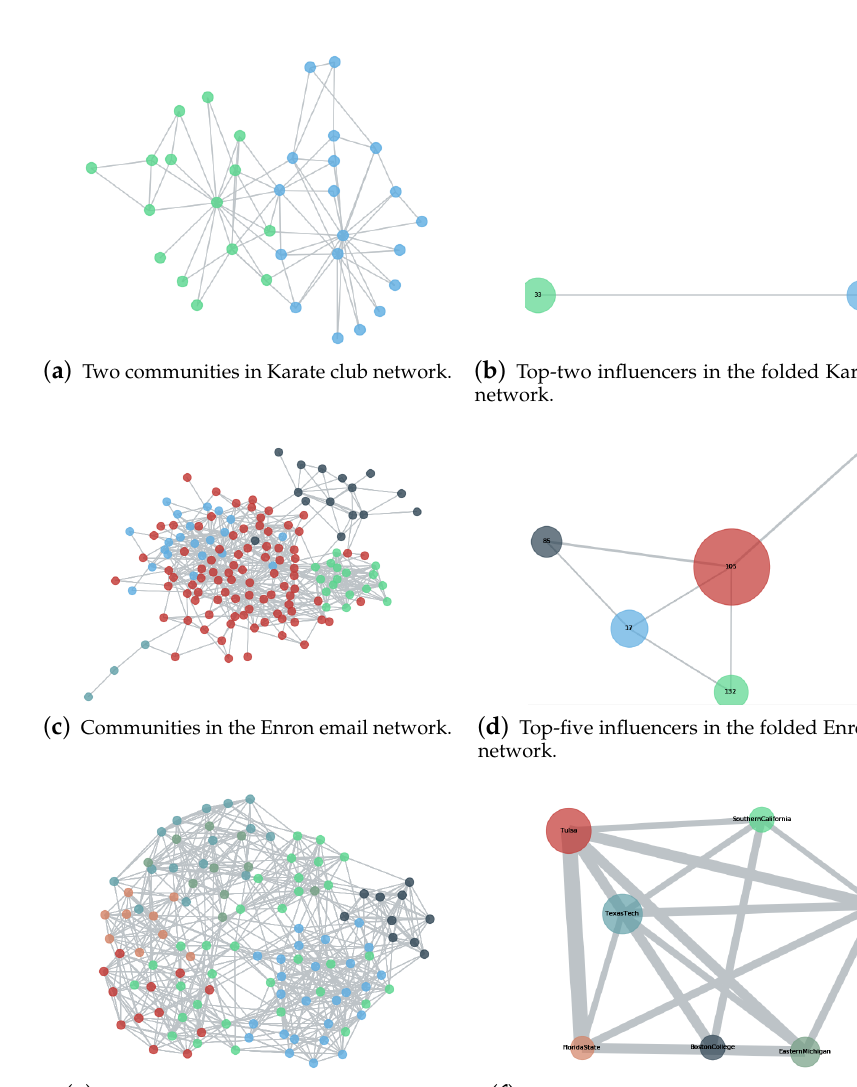
( e ) Communities in Football team network. ( f ) Top-seven influencers of the folded Football team network. Figure 1. Illustration of the proposed Maximum Influential Neighbors Expansion (MINE) algorithm. Communities in three real-world networks (i.e., Karate Club network [62], Enron email network [63] and College Football Team network [64]) are presented in the left three panels the and top-ranking nodes are highlighted in the right three panels, which suggests that the MINE algorithm aims to identifying vital nodes